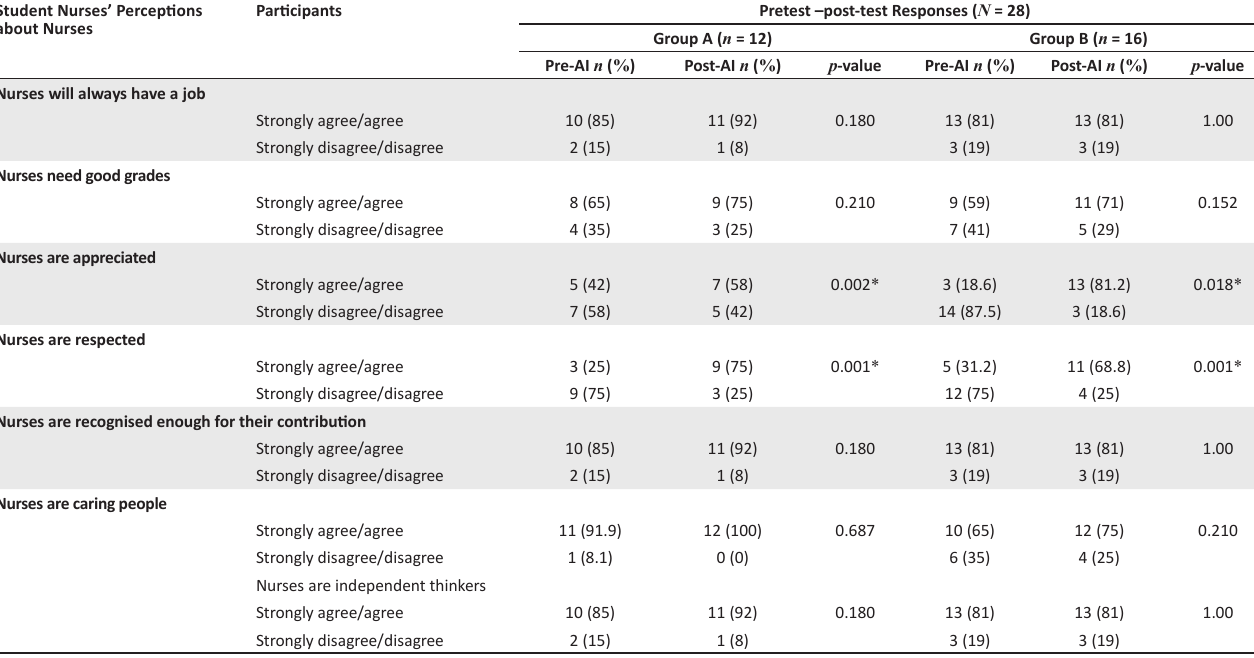
TABLE 3: Student nurses’ perceptions about nurses before and after appreciative inquiry intervention. Student Nurses’ Perceptions about Nurses